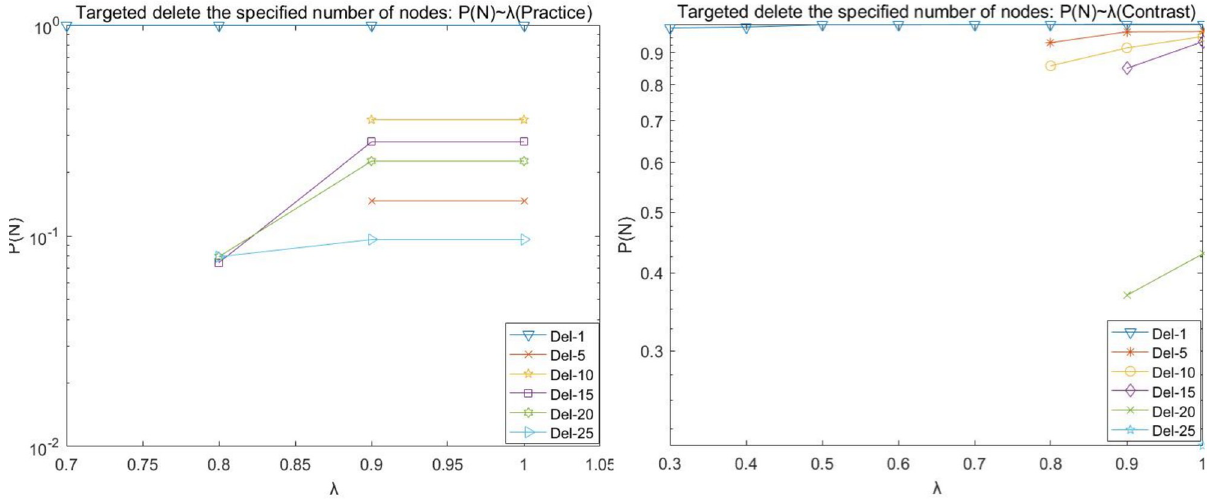
Fig 6. Target disruption- P ( N ) with λ variation diagram.